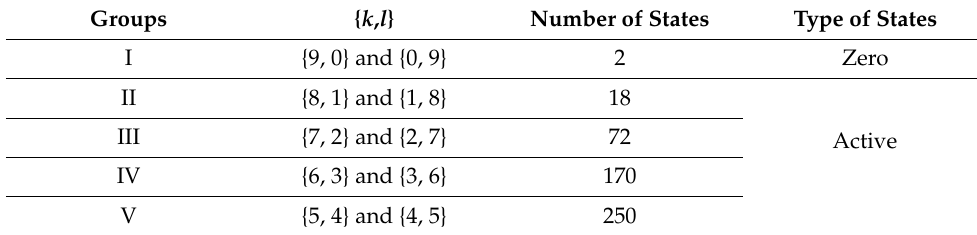
Table 1. Switching Combination Groups for nine-phase VSI. Groups { k , l } Number of States Type of States I {9, 0} and {0,